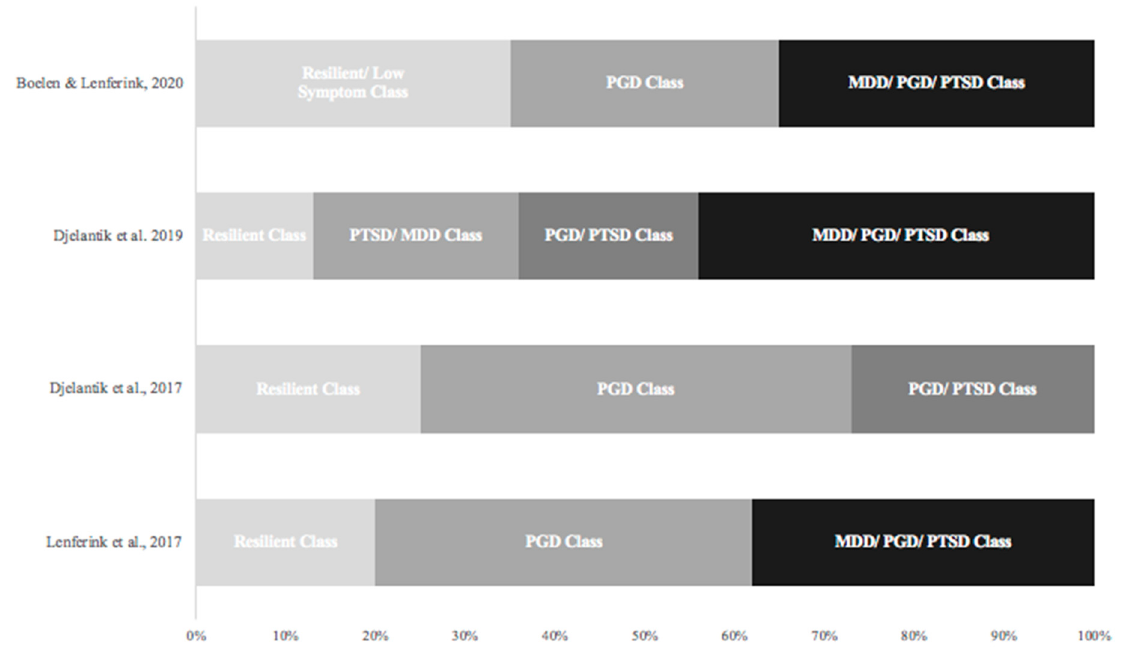
Figure 1. Summary of research findings on symptom profile classes following bereavement. Boelen & Lenferink, 2020 [21], Djelantik et al., 2017, 2019 [18,19], Lenferink et al., 2017 [20].